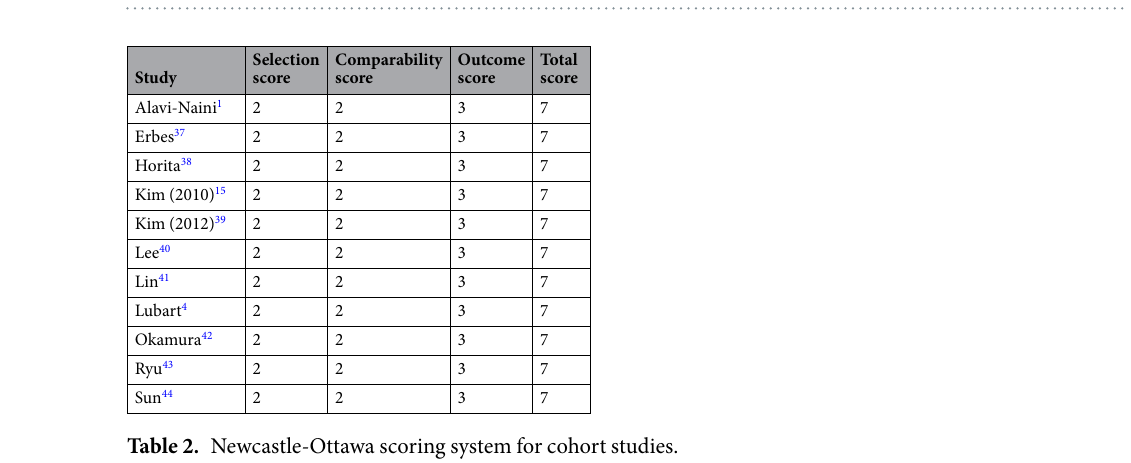
Table 1. Studies describing in-hospital mortality among pulmonary tuberculosis patients. ADL = activities of daily living; APACHE II = Acute Physiology and Chronic Health Evaluation; ARDS = acute respiratory distress syndrome; DM = Diabetes Mellitus; Hx = history; IHD = ischemic heart disease; TB = tuberculosis; PTB = pulmonary TB; NR = Not reported; WHO = World Health Organization.